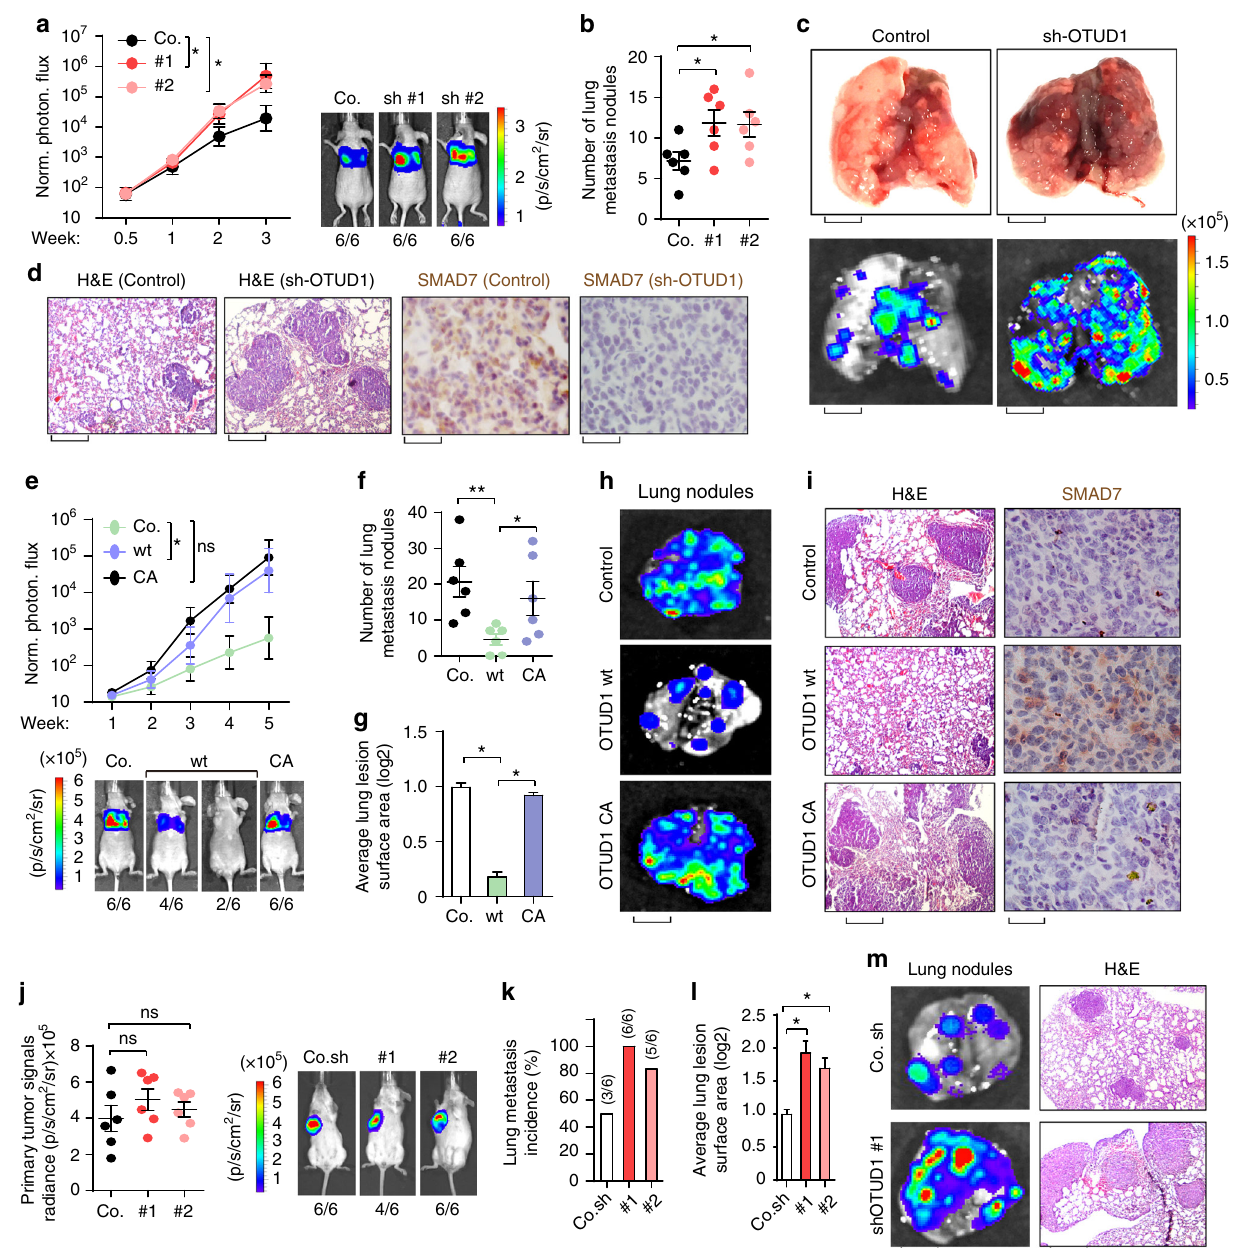
Fig. 7 OTUD1 inhibits lung metastasis in transplantable mouse models of breast cancer metastasis. a – d Control (Co.) or OTUD1-silenced (sh#1 and sh#2) 4T07 cells were tail vein-injected into nude mice. Lung metastasis was measured by BLI. Normalized photon fl ux at the indicated times left ( ± SD) and representative images (right) are shown; p- values; Student ’ s t- test ( a ). Lung metastasis nodules in each group were calculated ( ± SD) and the representative images of bright view ( c , upper panel; scale bar, 2 mm) and bioluminescent view ( c , lower panel; scale bar, 2 mm) are shown. Representative HE and IHC staining pictures of lung sections of control and one shRNA-depleted OTUD1 group ( d ), scale bars, 1 mm and 20 μ m for lung haematoxylin and eosin (H&E) and SMAD7 immunohistochemistry images, respectively). e – i Control (Co.) 4T1 cells or cells stably expressing OTUD1-wt or CA were tail vein-injected into nude mice. Lung metastasis was measured by BLI. Normalized photon fl ux ( ± SD) at the indicated times are shown in the upper panel and representative images in the lower; p values; Student ’ s t -test e . Lung metastasis nodules ( ± SD) f and average lung lesion surface area ( ± SD) g (arbitrary units based on pixel quanti fi cation from digital images) in each group were calculated and the representative images of bioluminescent view ( h , scale bar, 2 mm) are shown. Representative HE and IHC staining pictures of lung sections of every experimental group ( i , Scale bars, 1 mm and 20 μ m for lung haematoxylin and eosin (H&E) and SMAD7 immunohistochemistry images, respectively) are shown. j – m Control (Co.) or OTUD1-depleted 4T1 cells were orthotropic injected in syngeneic BALB/c mice. Primary tumor formation in mice after orthotropic injection of each group at day 21 after implantation. Normalized BLI signals ( ± SD) (Left) and representative BLI signals of primary tumor. Number of lung metastasis nodules ( k ) and average lung lesion surface area ( ± SD) (l) (arbitrary units based on pixel quanti fi cation from digital images). Representative bioluminescent view of isolated lung ( m , left, scale bar, 2 mm) and HE staining of lung section of each group ( m , right, scale bar, 20 μ m). * p < 0.05 and ** p < 0.01 (two-tailed Student ′ s t -test a – l